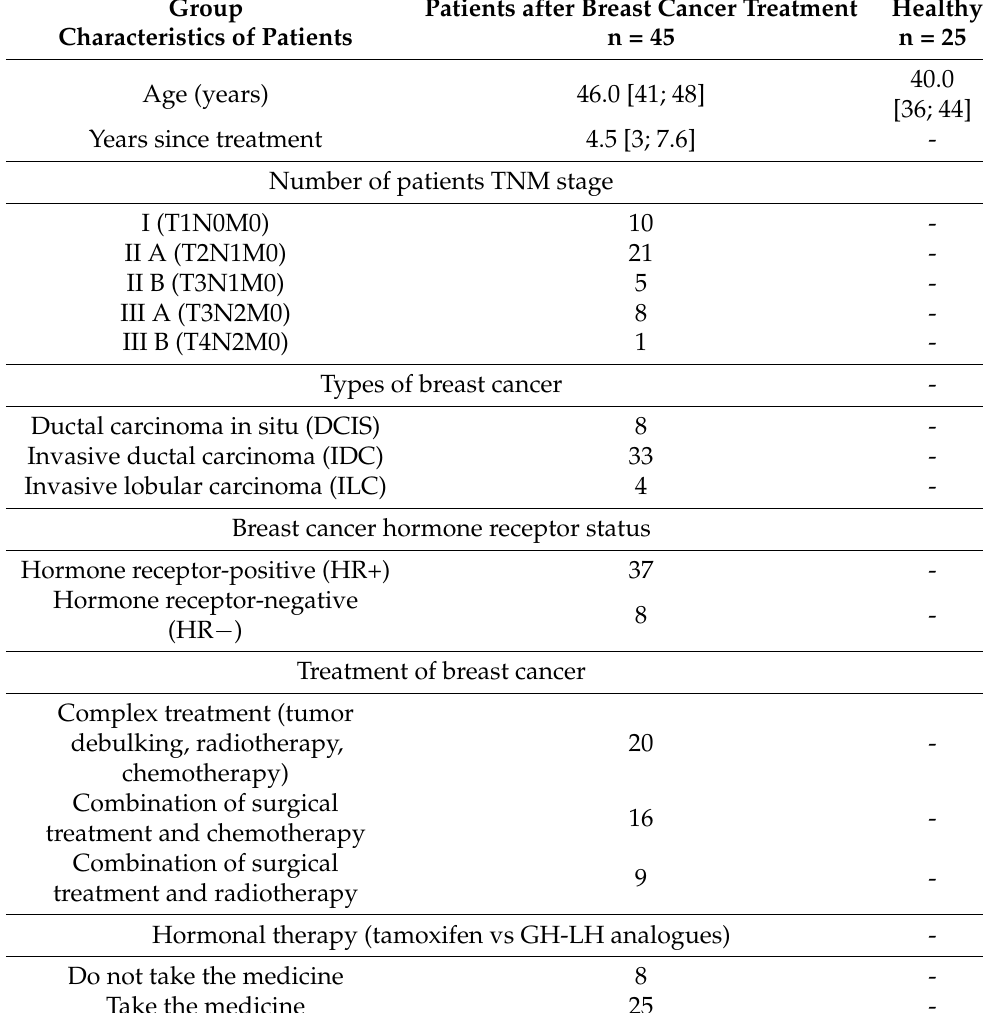
Table 1. Characteristics of the